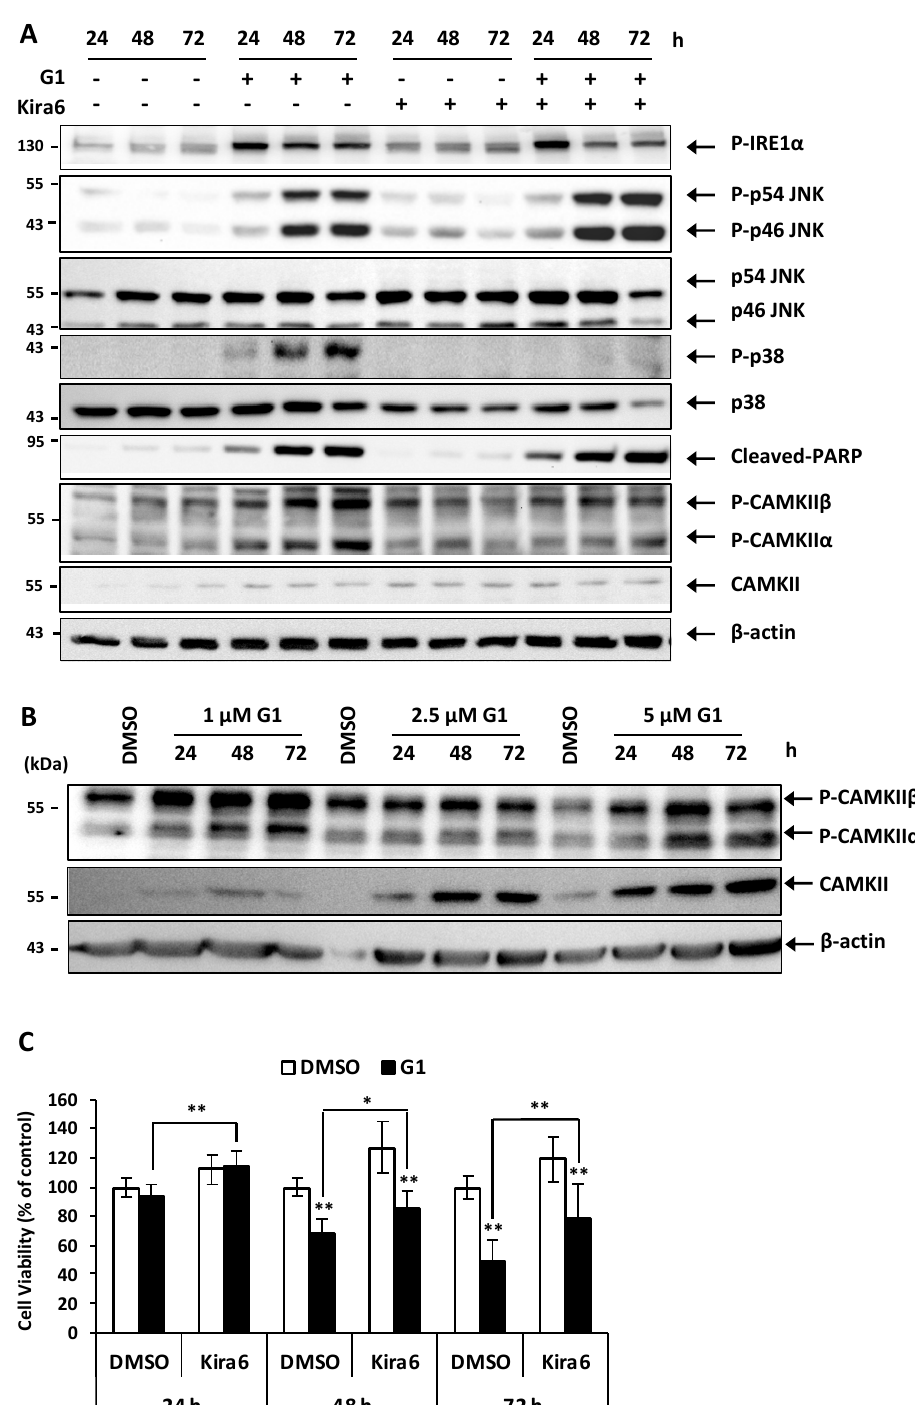
Figure 6. Inhibition of IRE1 α inhibited the phosphorylation of CAMKII and prevented G1-induced cell death in MCF-7 cells. MCF-7 cells were pretreated with 0.05 µ M Kira6, an inhibitor of IRE1 α for 1 h and then exposed to 1 µ M G1 for 24, 48 and 72 h. ( A )Total protein lysates were subjected to Western blotting using appropriate antibodies as indicated. ( C ) Cell viability was measured by the resazurin assay. ( B ) MCF-7 cells were treated with 1, 2.5 and 5 µ M G1 for 24, 48 and 72 h. Total protein lysates were subjected to Western blotting using appropriate antibodies as indicated. * p < 0.05, and ** p < 0.01 when compared with cells treated with vehicle or among G1-treated groups. + is indicated for the presence of a treatment meanwhile – is indicated for the absence of a treatment.